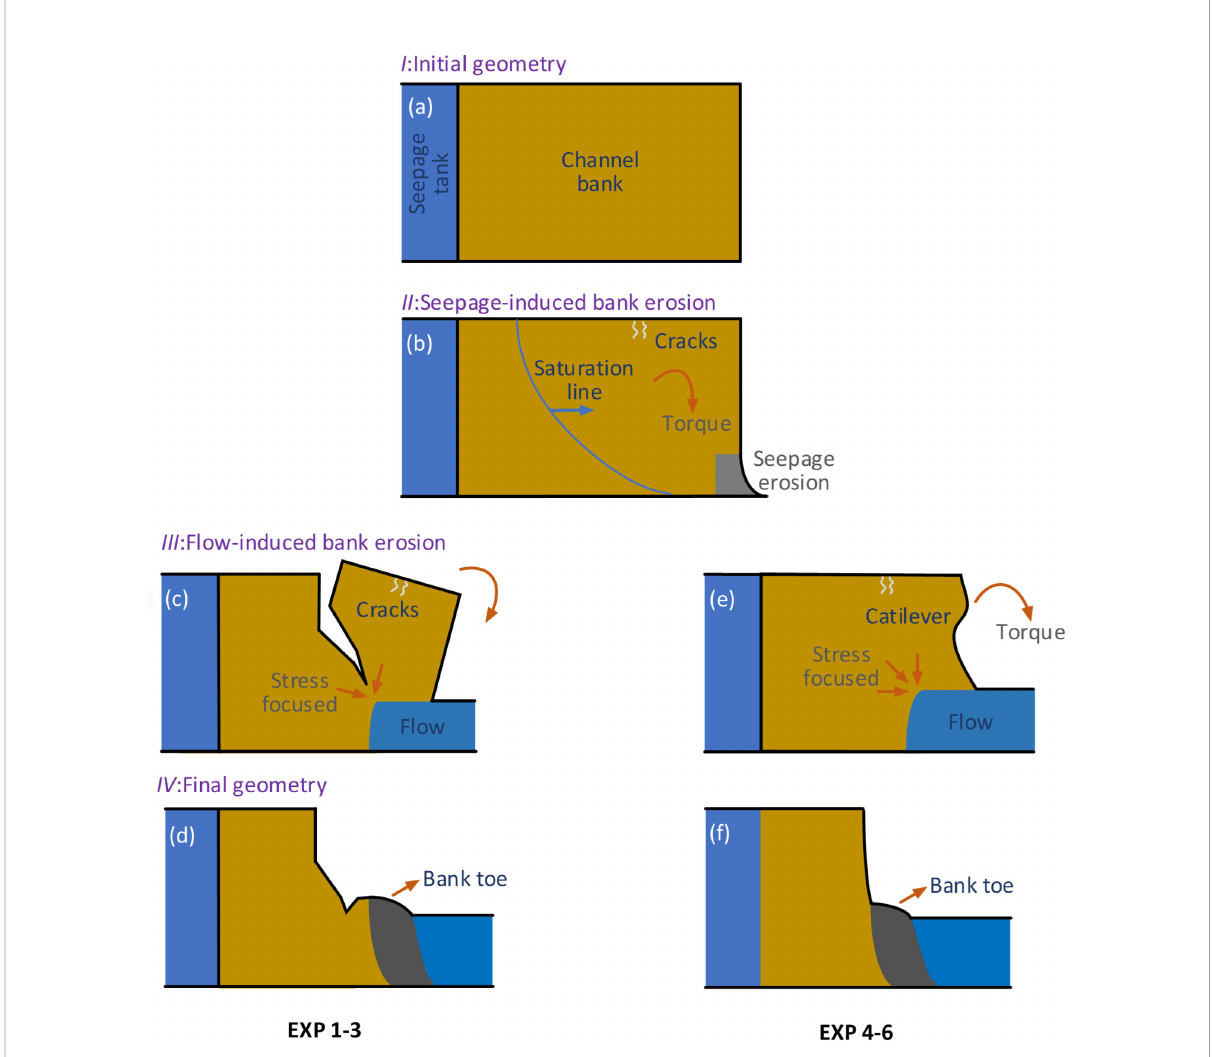
FIGURE 10 Conceptual sketch of the evolution of bank pro fi les. (A) Initial geometry; (B) Seepage-induced bank erosion; (C) Flow-induced bank erosion in 2D experiments; (D) Final geometry in 2D experiments; (E) Flow-induced bank erosion in 3D experiments; (F) Final geometry in 3D